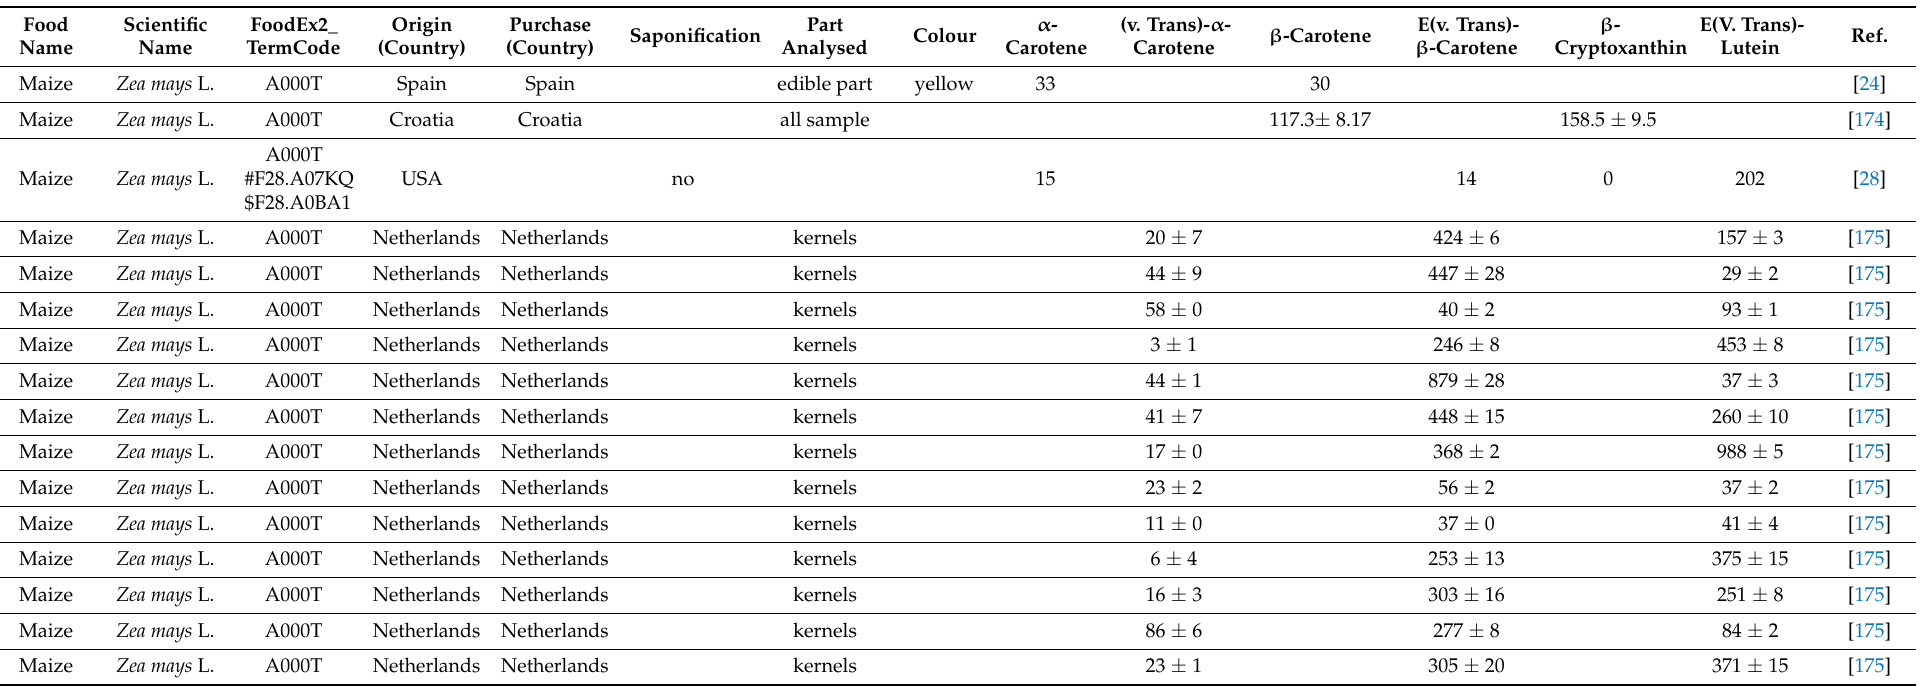
Table A4. Cereal grains (and cereal-like grains) (A000L) ( µ g/100